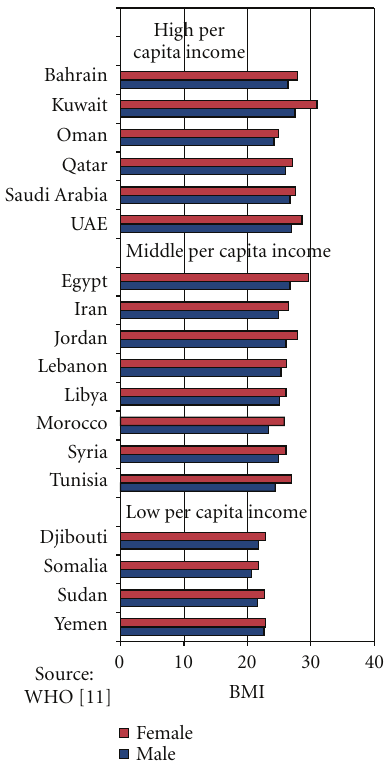
Figure 1: Mean BMI (kg/m 2 ) among adults in EMR countries according to per capita income